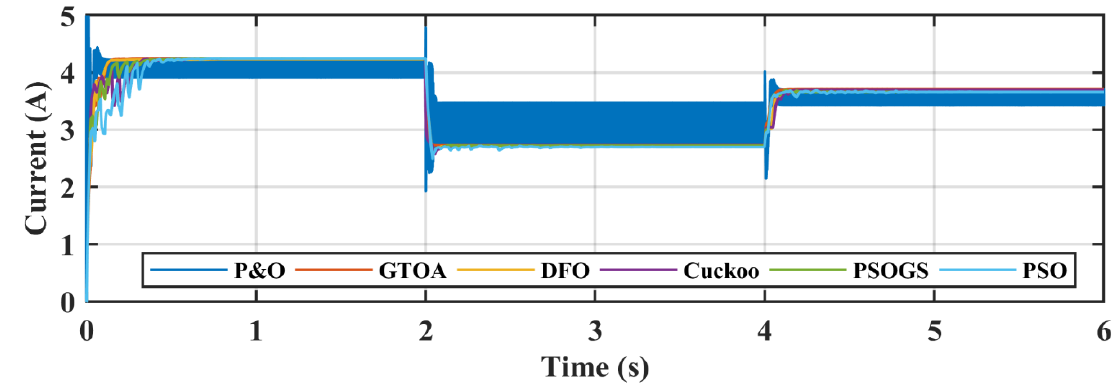
Electronics 2020 , 9 , x FOR PEER REVIEW Figure 13. Comparison of voltage transients of GTOA. Figure 13. Comparison of voltage transients of GTOA.